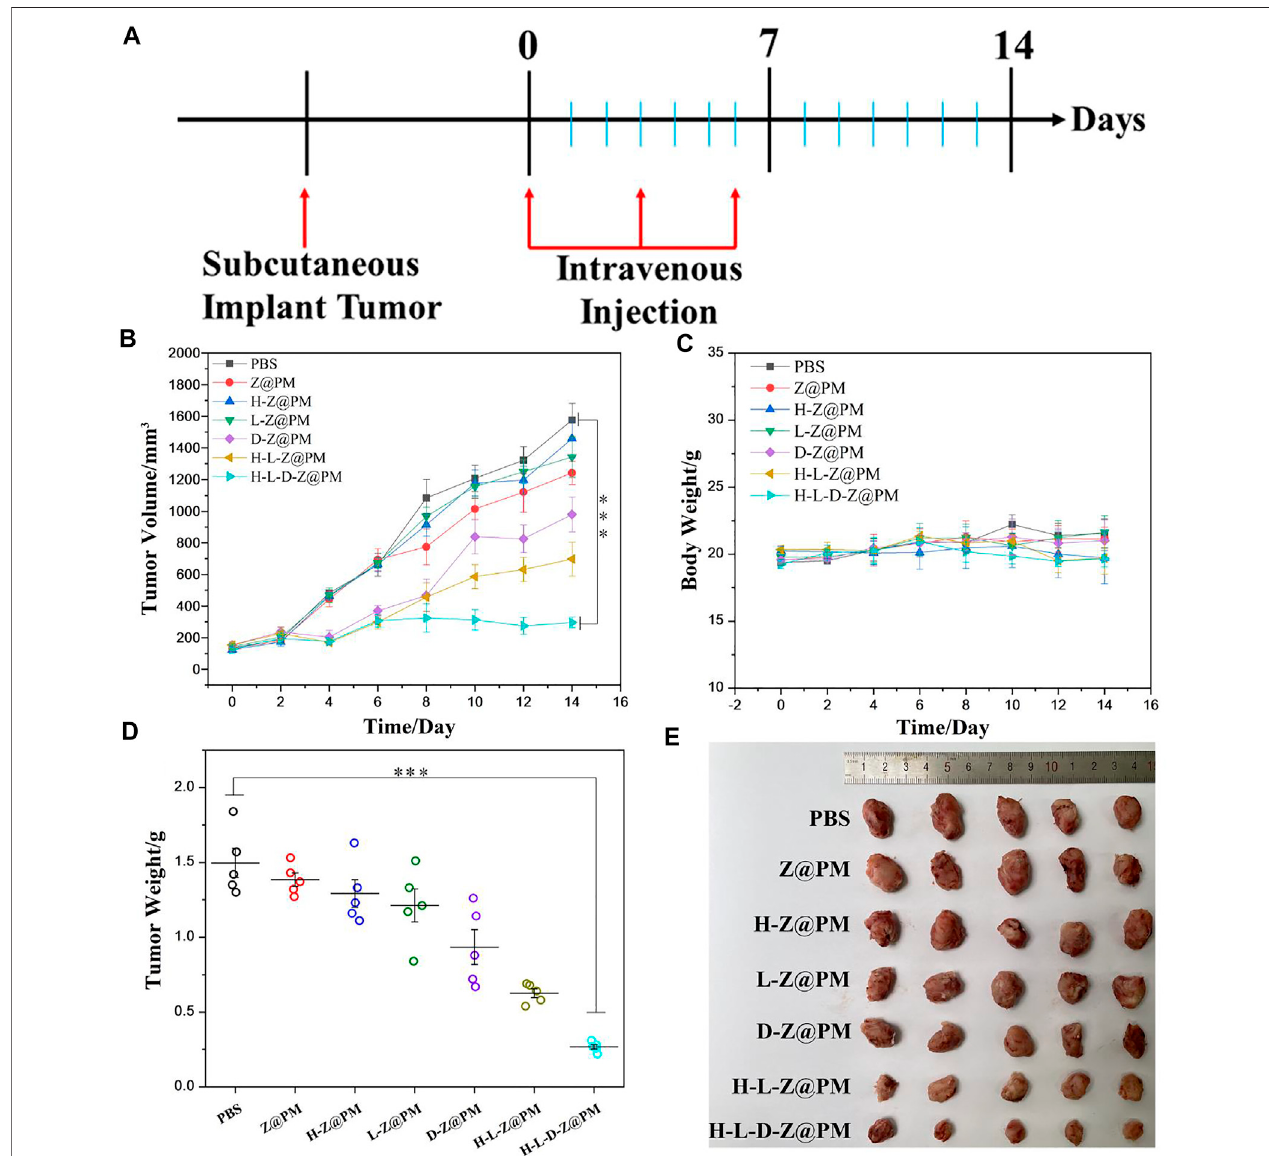
FIGURE6|(A) Illustrationoftheexperimentaldesign. (B) Tumorvolumeand (C) bodyweightafterdifferenttreatments. (D) Tumorweightafterdifferenttreatments. (E) Photos of tumor dissection. *** p < 0.001.